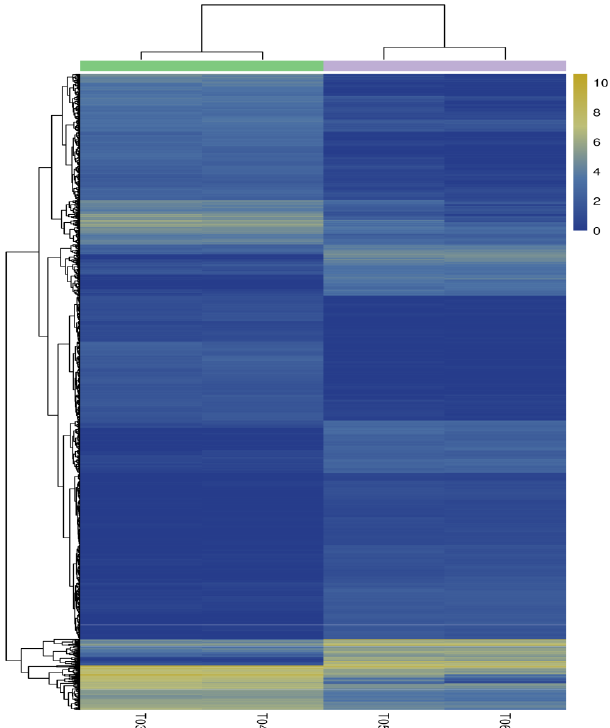
Figure 3. Heatmap of the differentially expressed genes. Columns indicate individual samples, and the row represents each differen- tially expressed genes. The color scale represents log10 (FPKM). Notes: T03 and T04 represent two biological replicates of Pekin ducks; T05 and T06 represent two biological replicates of mulard